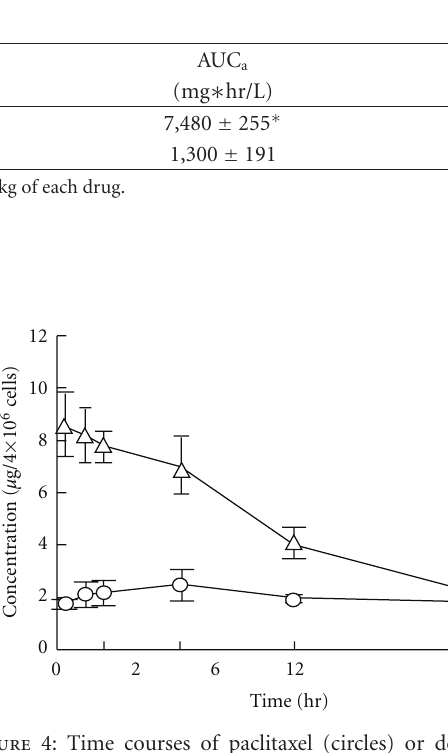
Figure 4: Time courses of paclitaxel (circles) or docetaxel (tri- angles) concentration in free tumor cells in the peritoneal cavity after an i.p. injection of 40mg/kg of Taxol or Taxotere into AH130 tumor-bearing rats [15]. Each point with bar represents the mean ± SD of three